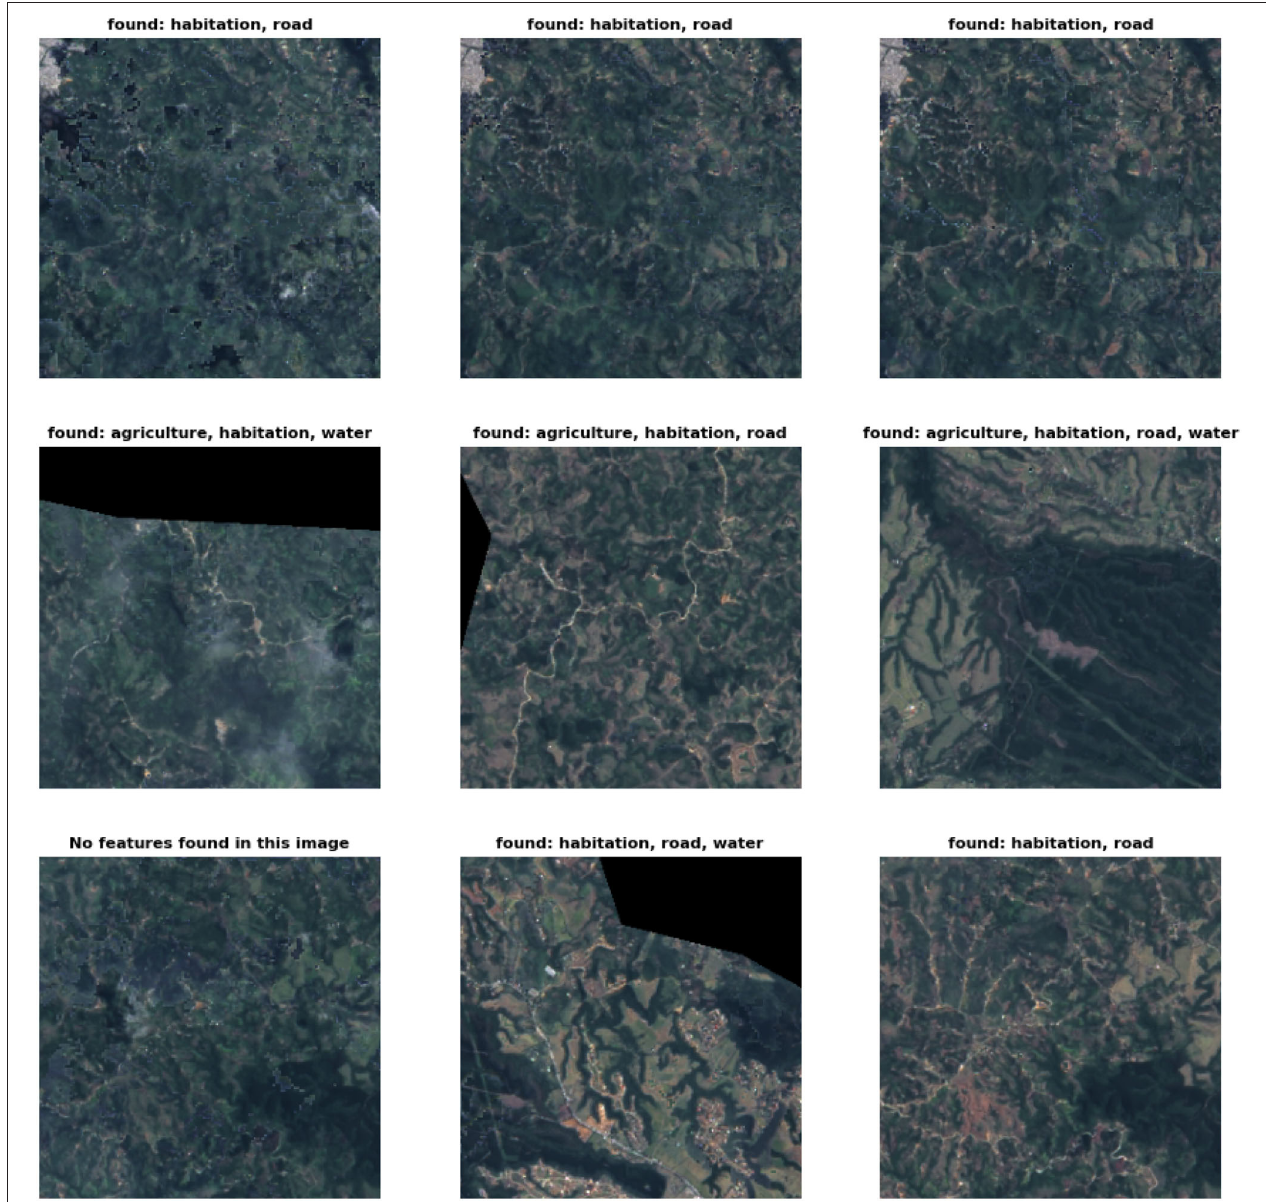
FIGURE 9 | Model predictions over Popayán patches. Examples of predictions generated over some patches of Popayán using the ResNet 50 model with highest f1-score in extraction of 4 features from satellite images. Above each patch are the characteristics that were found or if none of the 4 characteristics were found, it is indicated that no characteristics were found in that